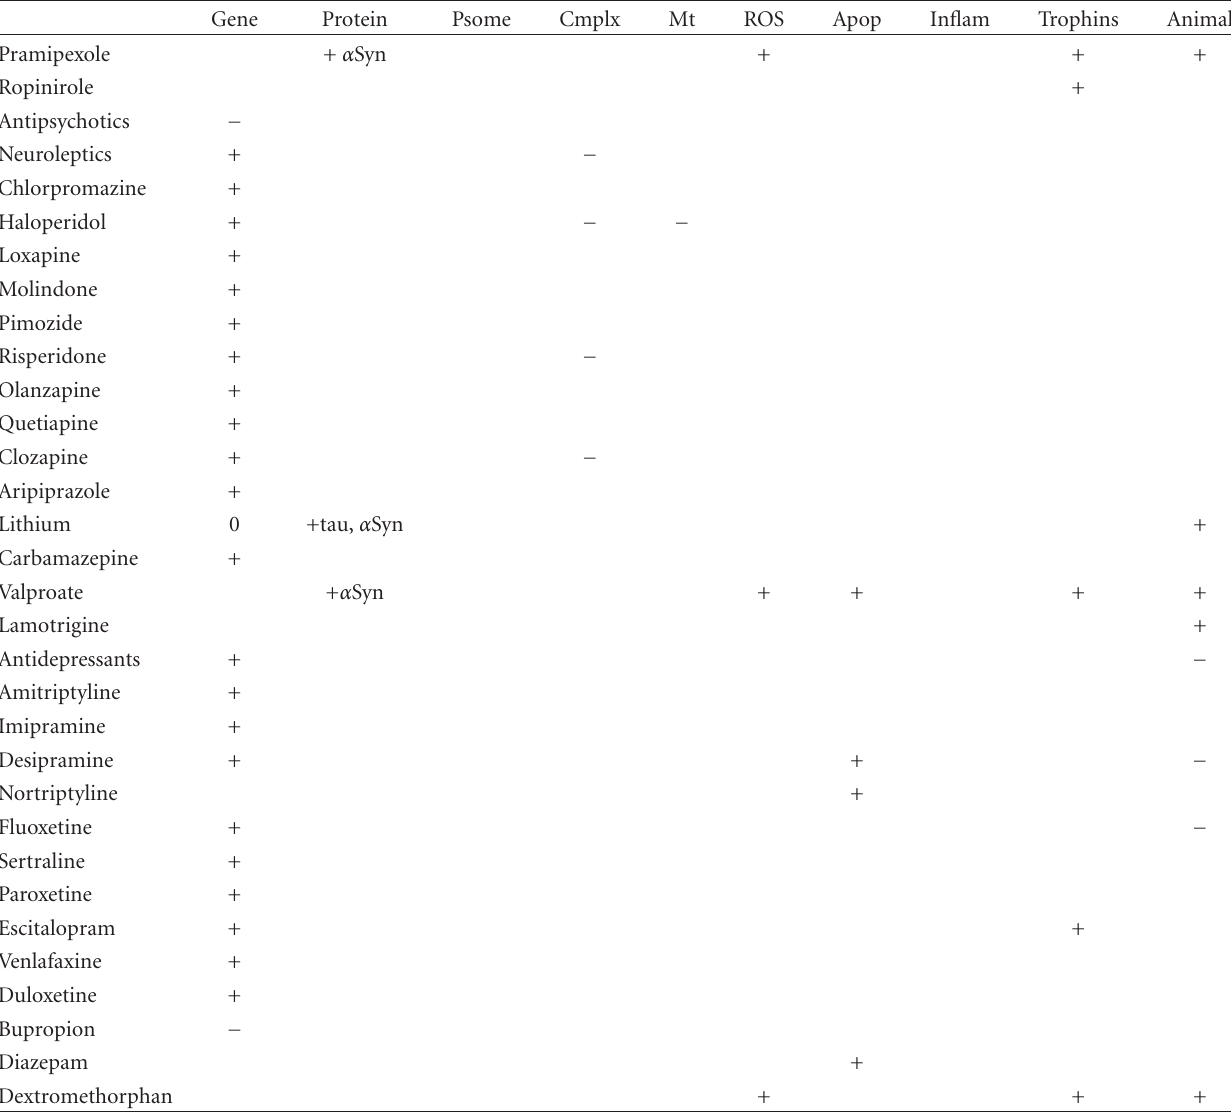
Table 1: Preclinical e ff ects of psychotropics on PD